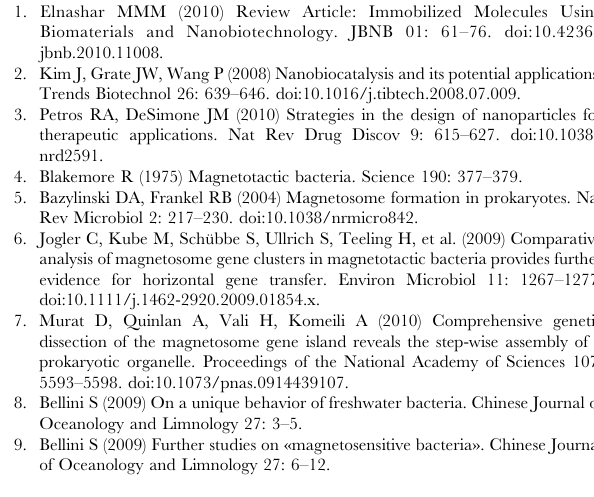
Sequence for cloning in pET100